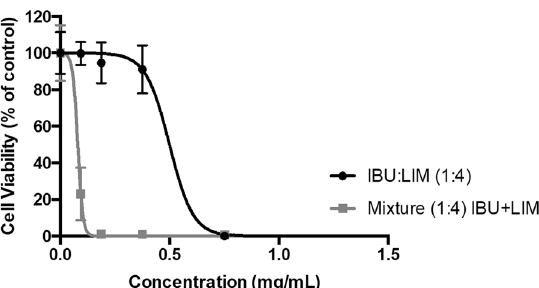
Figure 3. Comparing antiproliferative effect of THEDES and a mixture of IBU and LIM. IBU:LIM (1:4), and a mixture of IBU and LIM were compared in terms of antiproliferative activity using HT29 cell model treated for 24 hours. Results were expressed relatively to the control as mean ± SD of three independent experiments performed in